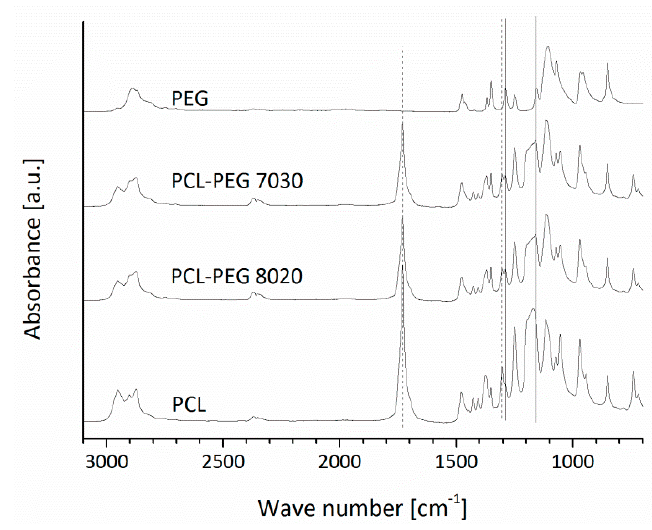
Figure 3. FTIR spectra of PCL, PCL-PEG blend and PEG plotted plates (the relevant peaks are discussed in the text).